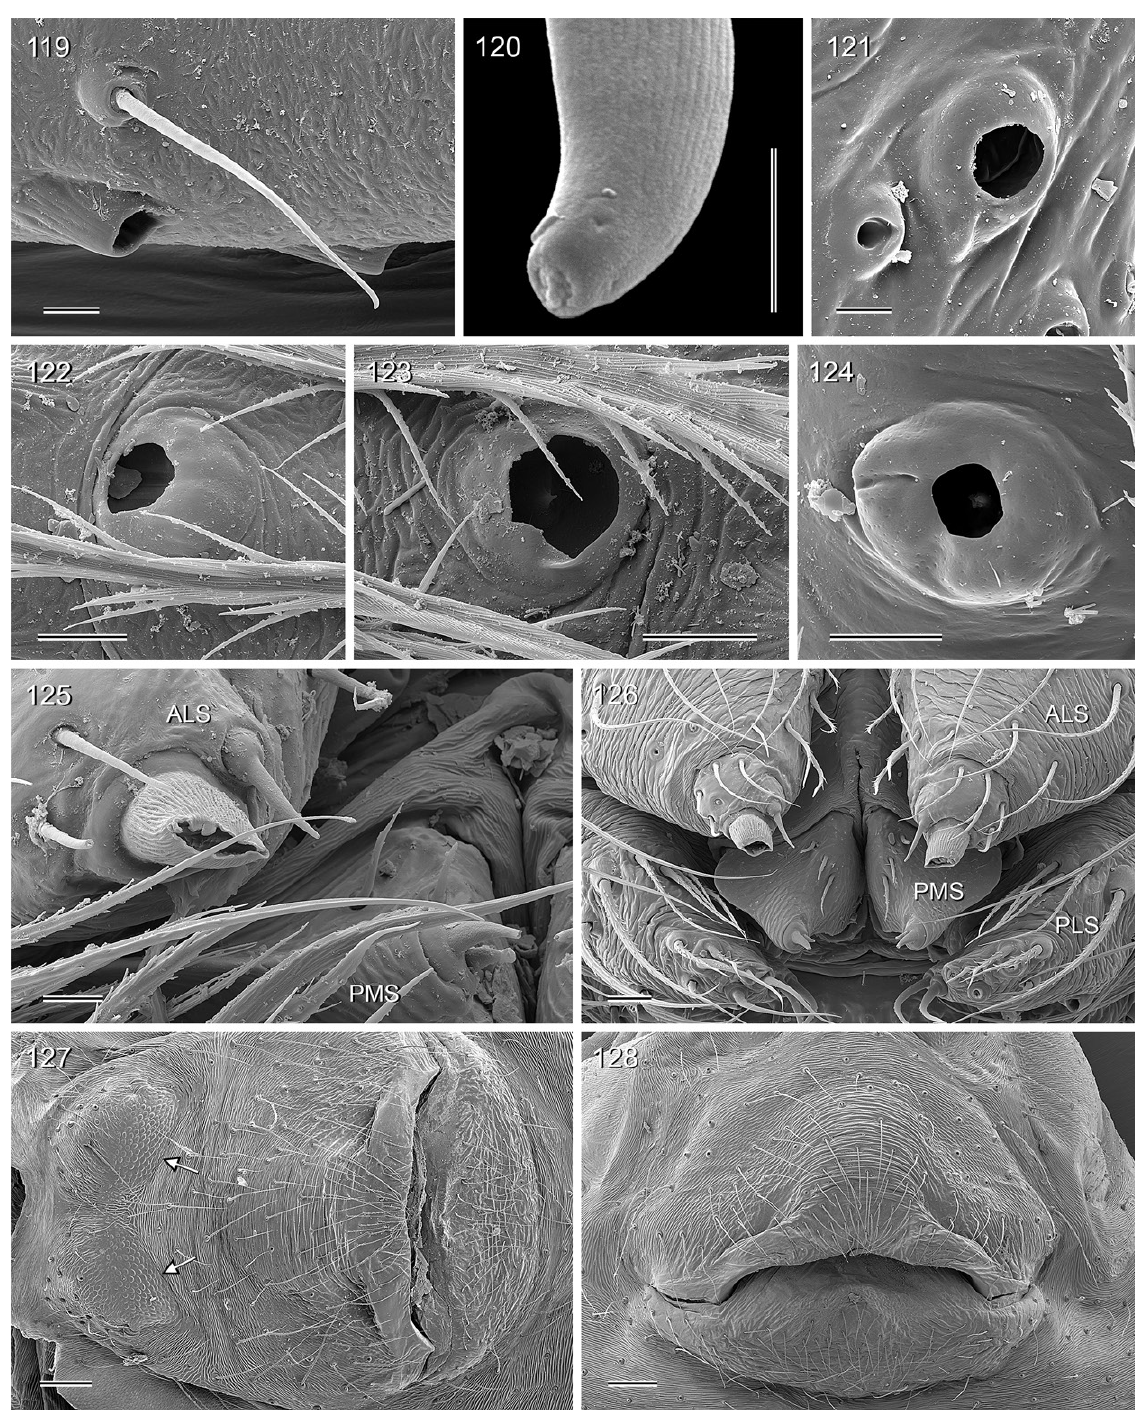
Figs 119–128. Holocnemus caudatus (Dufour, 1820); male and female from Spain, Granada, Trevélez (MHNG). 119 . ‘Short vertical hair’ on male metatarsus 4. 120 . Tip of hair from preceding figure. 121 . Male palpal tarsal organ. 122–123 . Tarsal organs on male tarsi 1 and 4. 124 . Female palpal tarsal organ. 125–126 . Male and female spinnerets. 127–128 . Epigyna and anterior epigynal humps (arrows). Scale bars: 119, 121–125 = 10 µm; 120 = 1 µm; 126 = 20 µm; 127–128 = 100